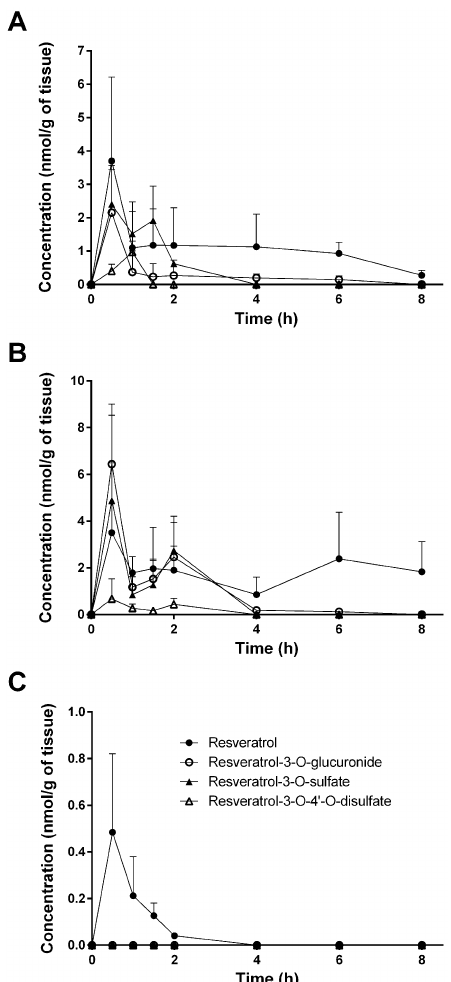
Figure 3. Tissue concentrations of resveratrol and its metabolites in heart ( A ), lung ( B ), and brain ( C ) after a single intragastric gavage of 10 mg/kg of resveratrol in mice. Values are presented as the mean ± SD; n = 3.